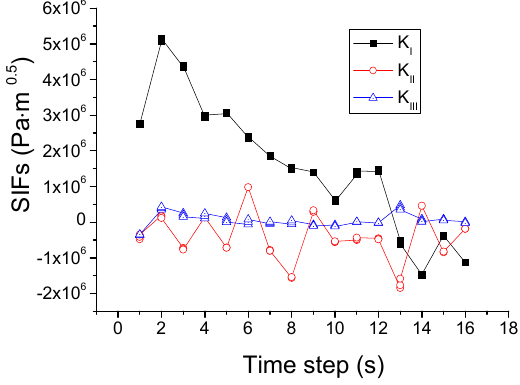
Figure 21. Variation of SIFs associated with the CTOA-based crack growth criterion.